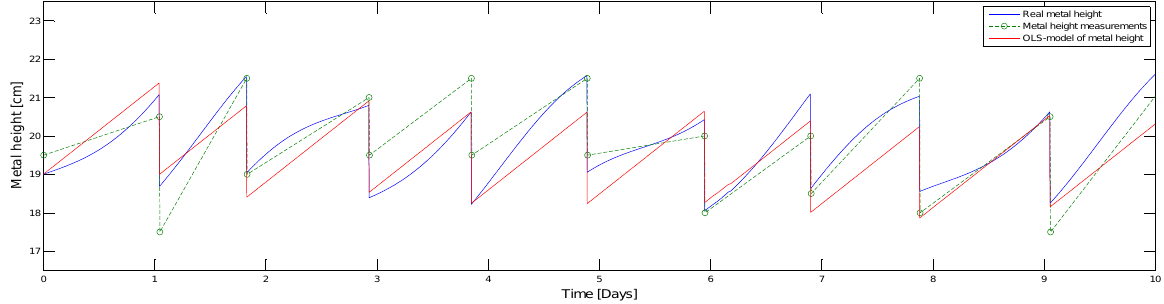
Figure 6: Prediction of metal height for the earlier presented synthetic data set showing fairly well correlation between the simulated and predicted values. The prediction model is based on the OLS algorithm and the noisy metal height measurements, just before and just after metal tapping, shown with the green circles in the